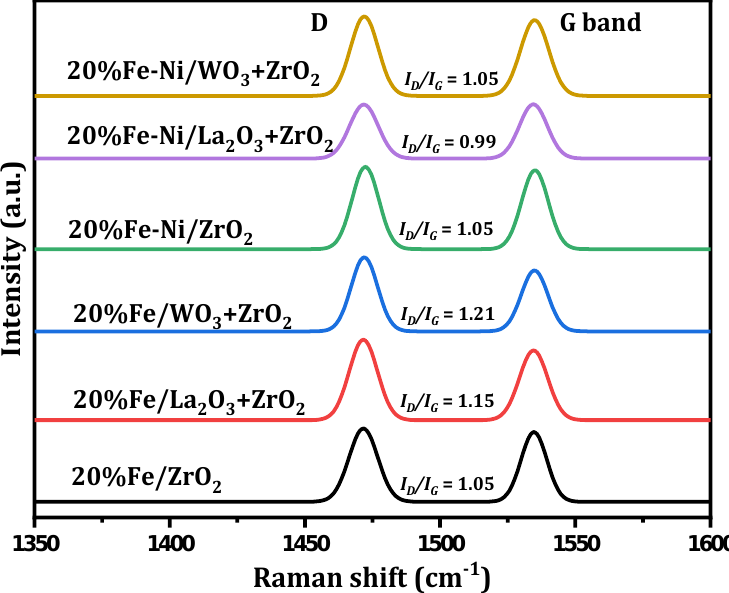
Figure 7. Raman analysis of spent supported Fe and Fe-Ni catalysts.